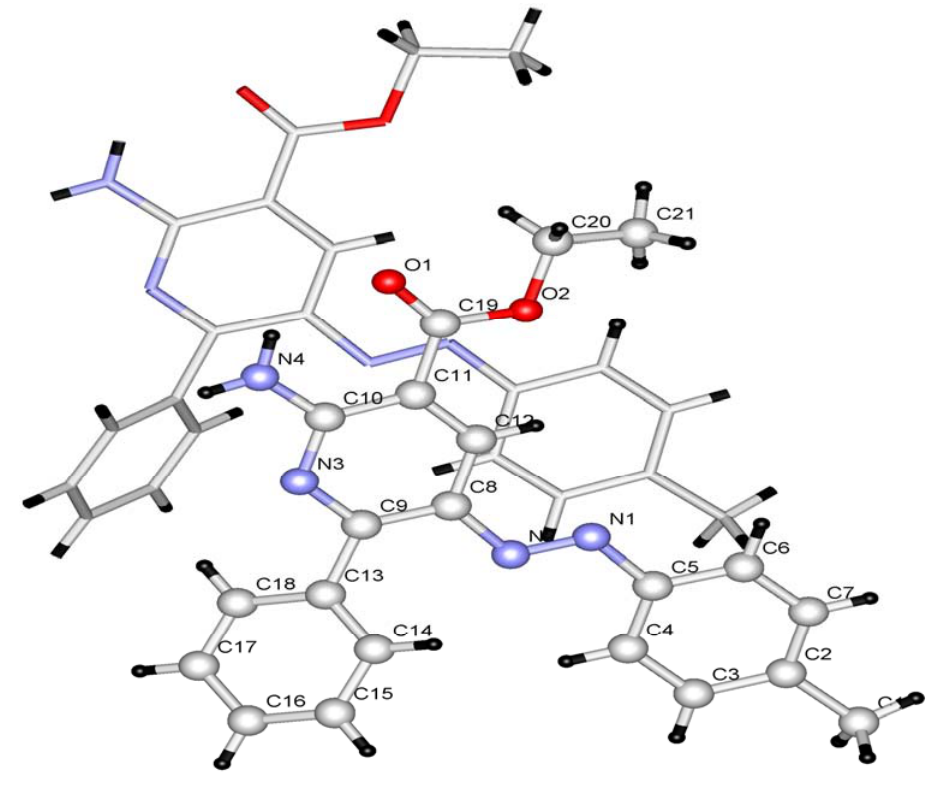
Figure 2. Ball and stick drawing of 8a